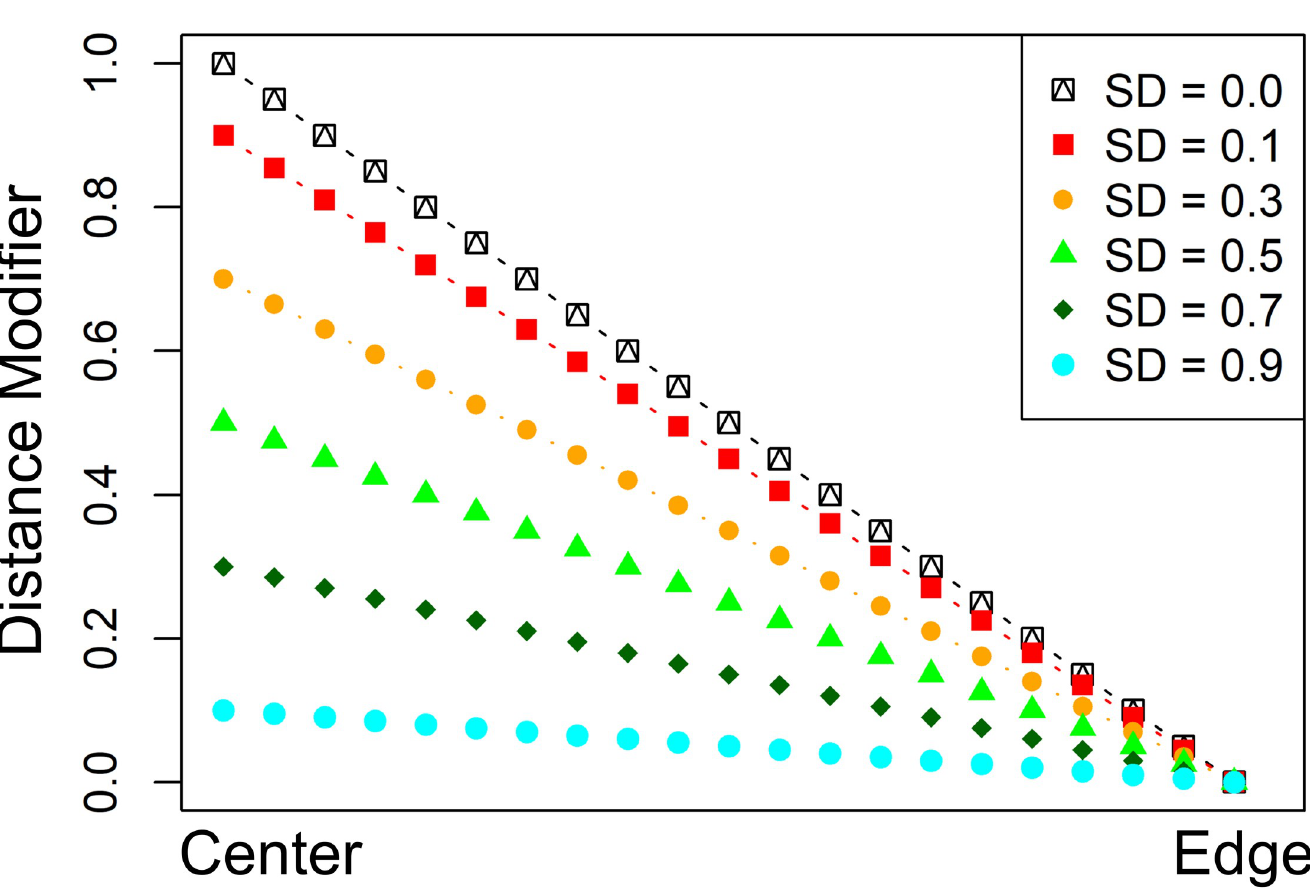
Fig 4. Distance modifier. Distance modifier to pixel transition probabilities, as a function of distance to center and local standard deviation of transition probabilities. Note how as the standard deviation increases, the impact of the distance modifier is